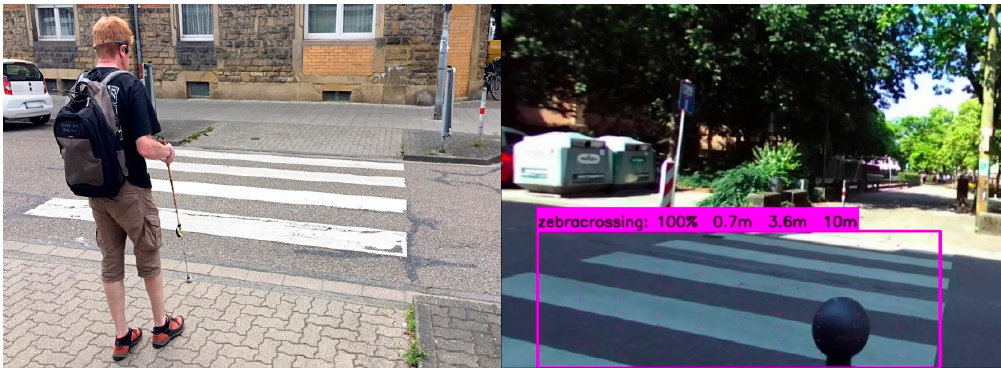
Figure 1. Detection of zebra crossings by analysis of the current environment 3 (photographs: D. Koester, with representative tones, use of Spearcons, Acusticons, and so on.